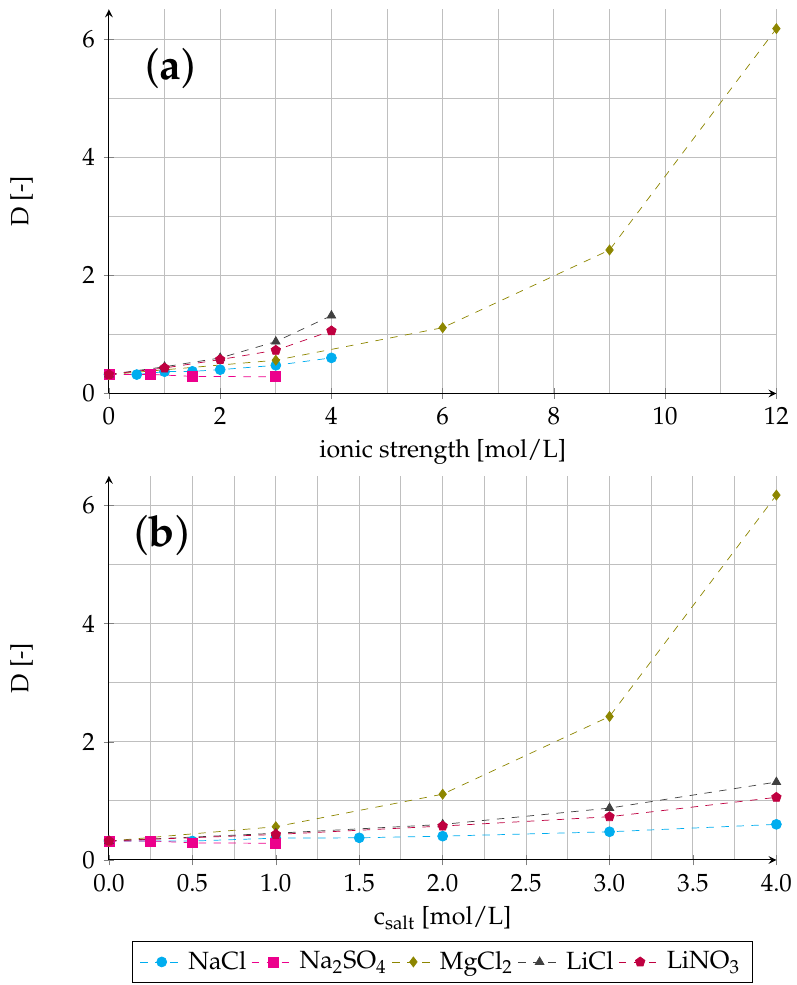
Figure 6. Effect of ionic strength ( a ) and concentration of different salts ( b ) on the distribution ratio by the extraction of boric acid by 2-ethyl-1-hexanol dissolved in kerosene (experiment (2) , Table 1). In comparison to n -octanol and 2-butly-1-octanol, 2-ethyl-1-hexanol showed the high- est distribution ratio at high ionic strength (Figure 7). Furthermore, the difference in the distribution ratio increased with the increase in the ionic